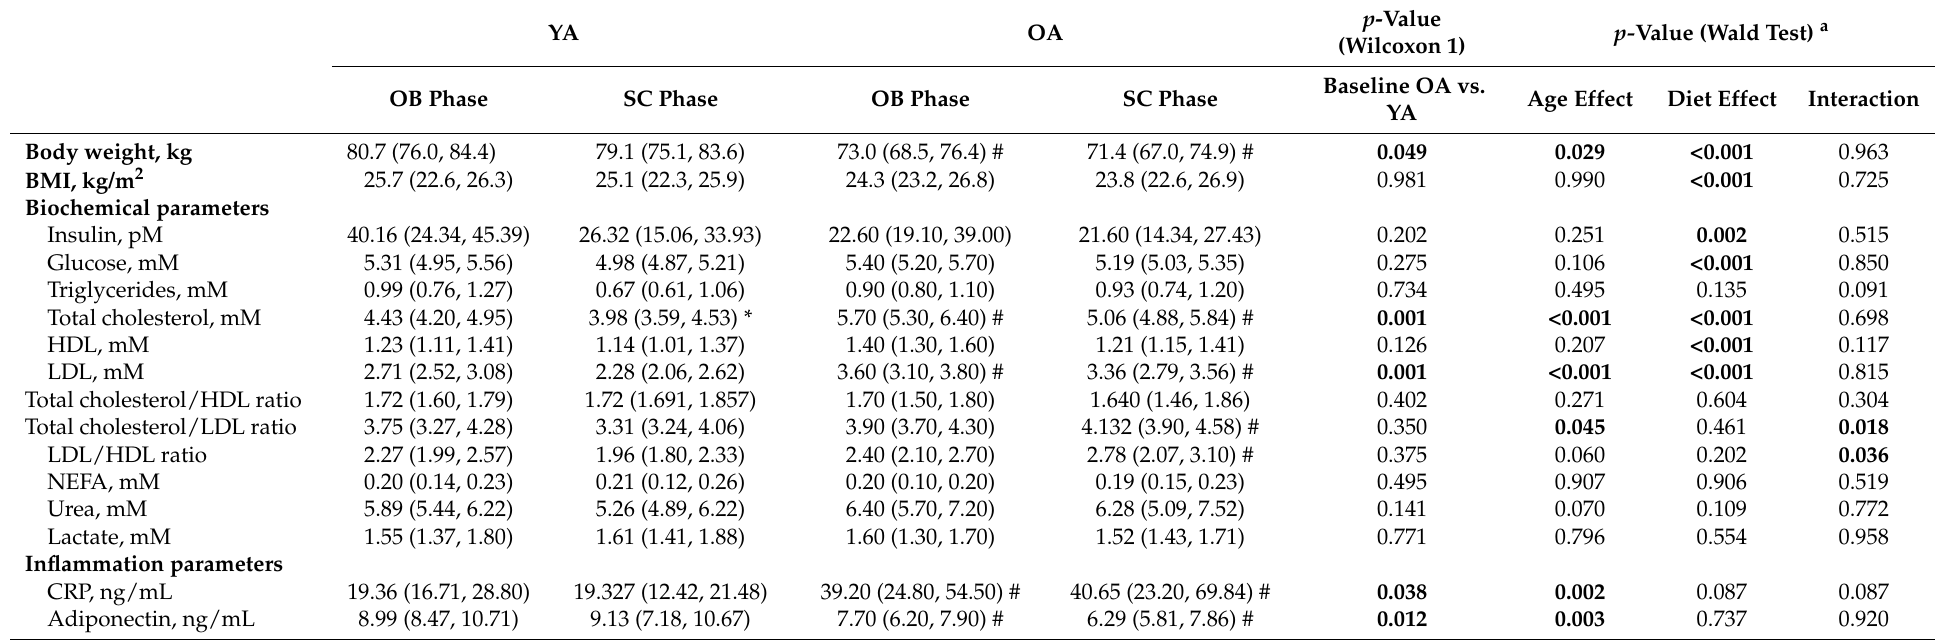
Table 3. Fasting clinical parameters (median (IQR)) during observation and semi-controlled diet periods in young and older